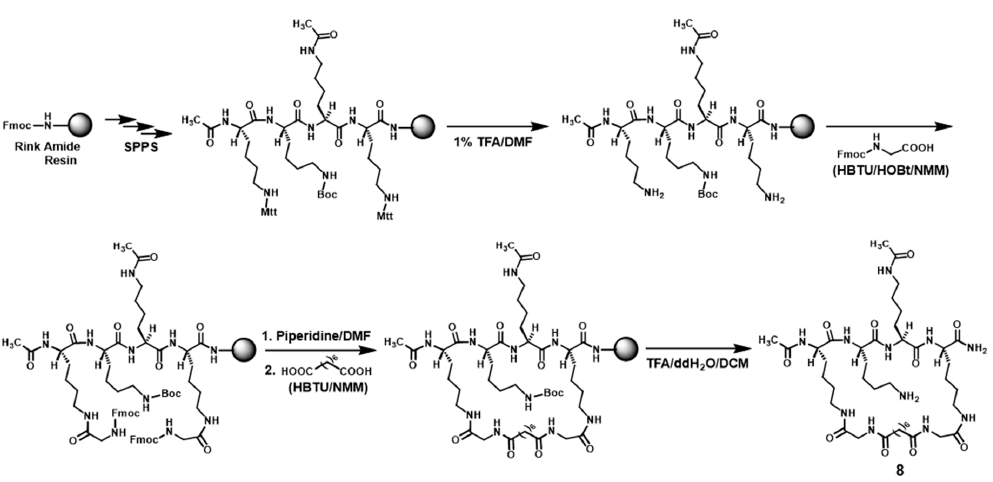
Scheme 3. The synthetic scheme of compound 8 . Table 2. The kinetic parameters for compounds 5 / 6 ’s substrate activities with SIRT1/2/3 a . Compound 5 6 Sirtuin